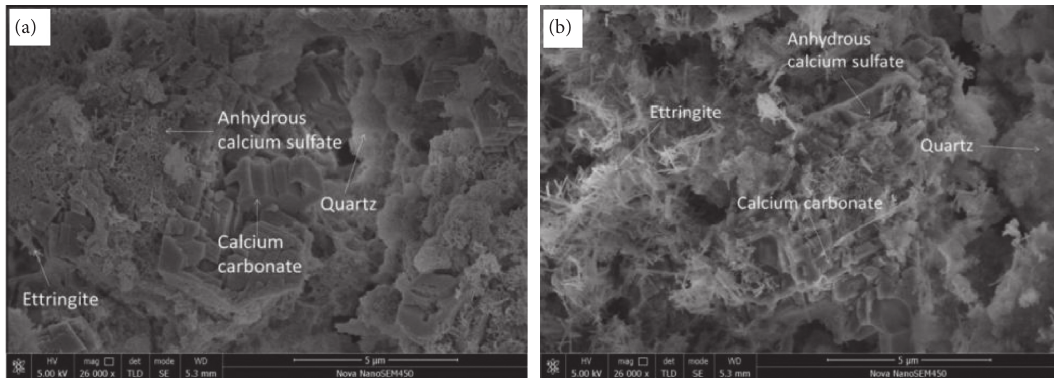
Figure 12: SEM images of the surface of (a) 4-S-12 (26000 times) and (b) 4-B-12 (26000